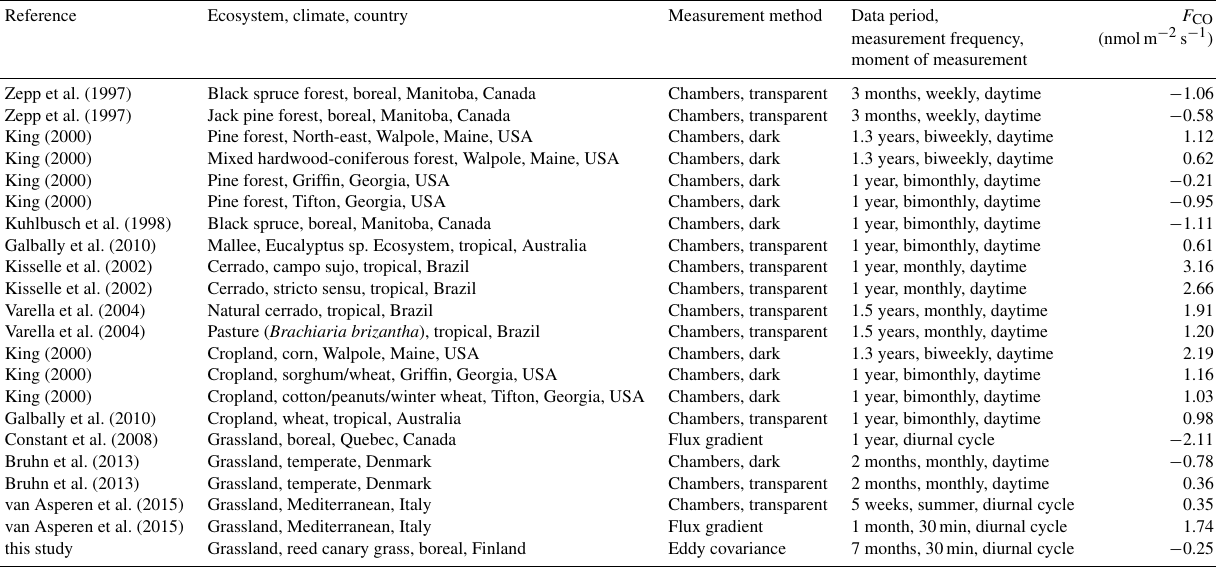
Table 5. Reported CO fluxes measured in different ecosystems and climatic regions, using chambers (transparent or dark), micrometeorolog- ical flux gradient or eddy covariance methods and the reported data period, measurement frequency and the moment of the